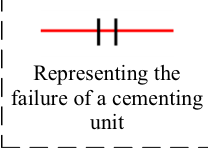
Transformation rule: In each group of 4 cementing units, when at least 3 units are broken, the damage of the cementing units is considered, and the damage of the cement member is exhibited at the next level.